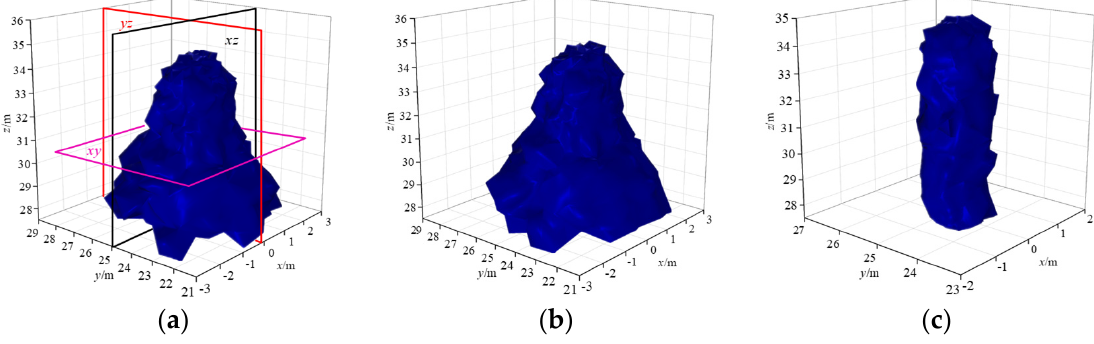
Figure 4. Diffusion morphology of grout under different lateral coefficients. ( a ) λ x = 3, λ y = 3; ( b ) λ x = 3, λ y = 0.75; ( c ) λ x = 0.75, λ y = 3.